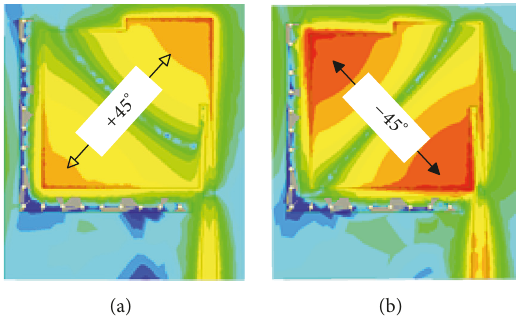
Figure 6: Electric field distribution of quarter-mode: (a) mode A QM ; (b) mode B QM .